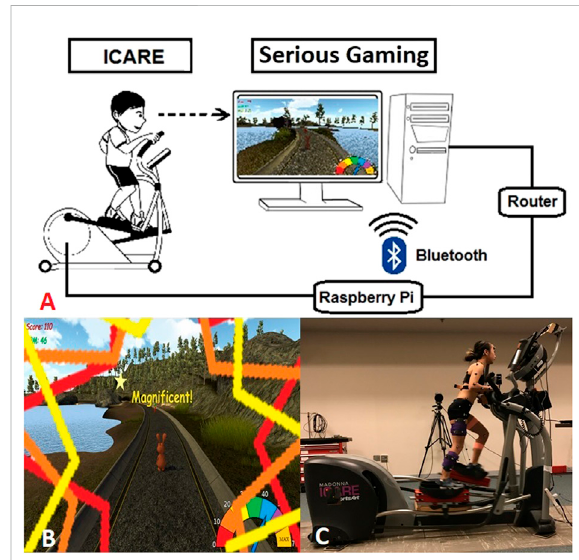
FIGURE 1 (A) The conceptual framework of non-immersive VR-ICARE (top). (B) The monitor positioned at eye-level in front of the ICARE console delivered positive visual and auditory feedback in the VR- enhanced gaming environment while a bunny collected carrots (bottom left). (C) Kinematic and electromyographic data were recorded simultaneously as participant used a modi fi ed ICARE during the VR-enhance ’ d ’ condition (bottom